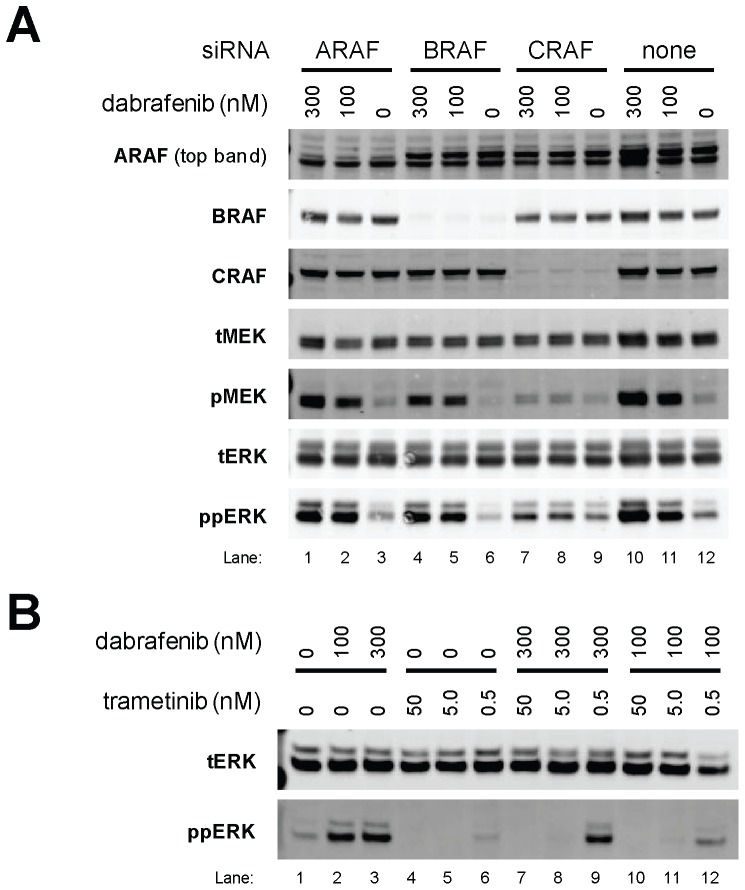
Dabrafenib-induced MAPK activation in wild-type BRAF/mutant RAS cells is CRAF-dependent and abrogated by MEK inhibition.In order to assess the individual contributions of ARAF, BRAF, and CRAF to paradoxical MAPK activation caused by dabrafenib in HCT-116 (wild-type BRAF, mutant KRAS) cells, phospho and total MEK (pMEK, tMEK) and ERK (pERK, tERK) were evaluated by immunoblot after a 72-hour incubation with siRNA towards ARAF, BRAF, or CRAF, or medium (none), and treatment with 0, 100, or 300 nM dabrafenib for 1 h (A). Sensitivity of this paradoxical activation to MEK inhibition was evaluated in HCT-116 cells, following treatment with 0, 100, or 300 nM dabrafenib for 1 h in the presence of 0, 0.5, 5.0, or 50 nM MEK inhibitor (trametinib). Lysates were immunoblotted for total ERK (tERK) and dual-phosphorylated ERK (ppERK) (B).